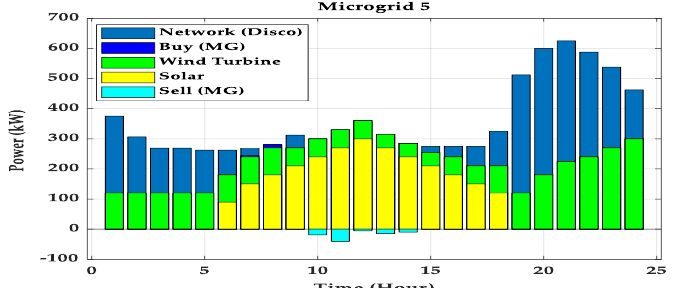
Figure 12. Microgrid 5’s load and generation profile.